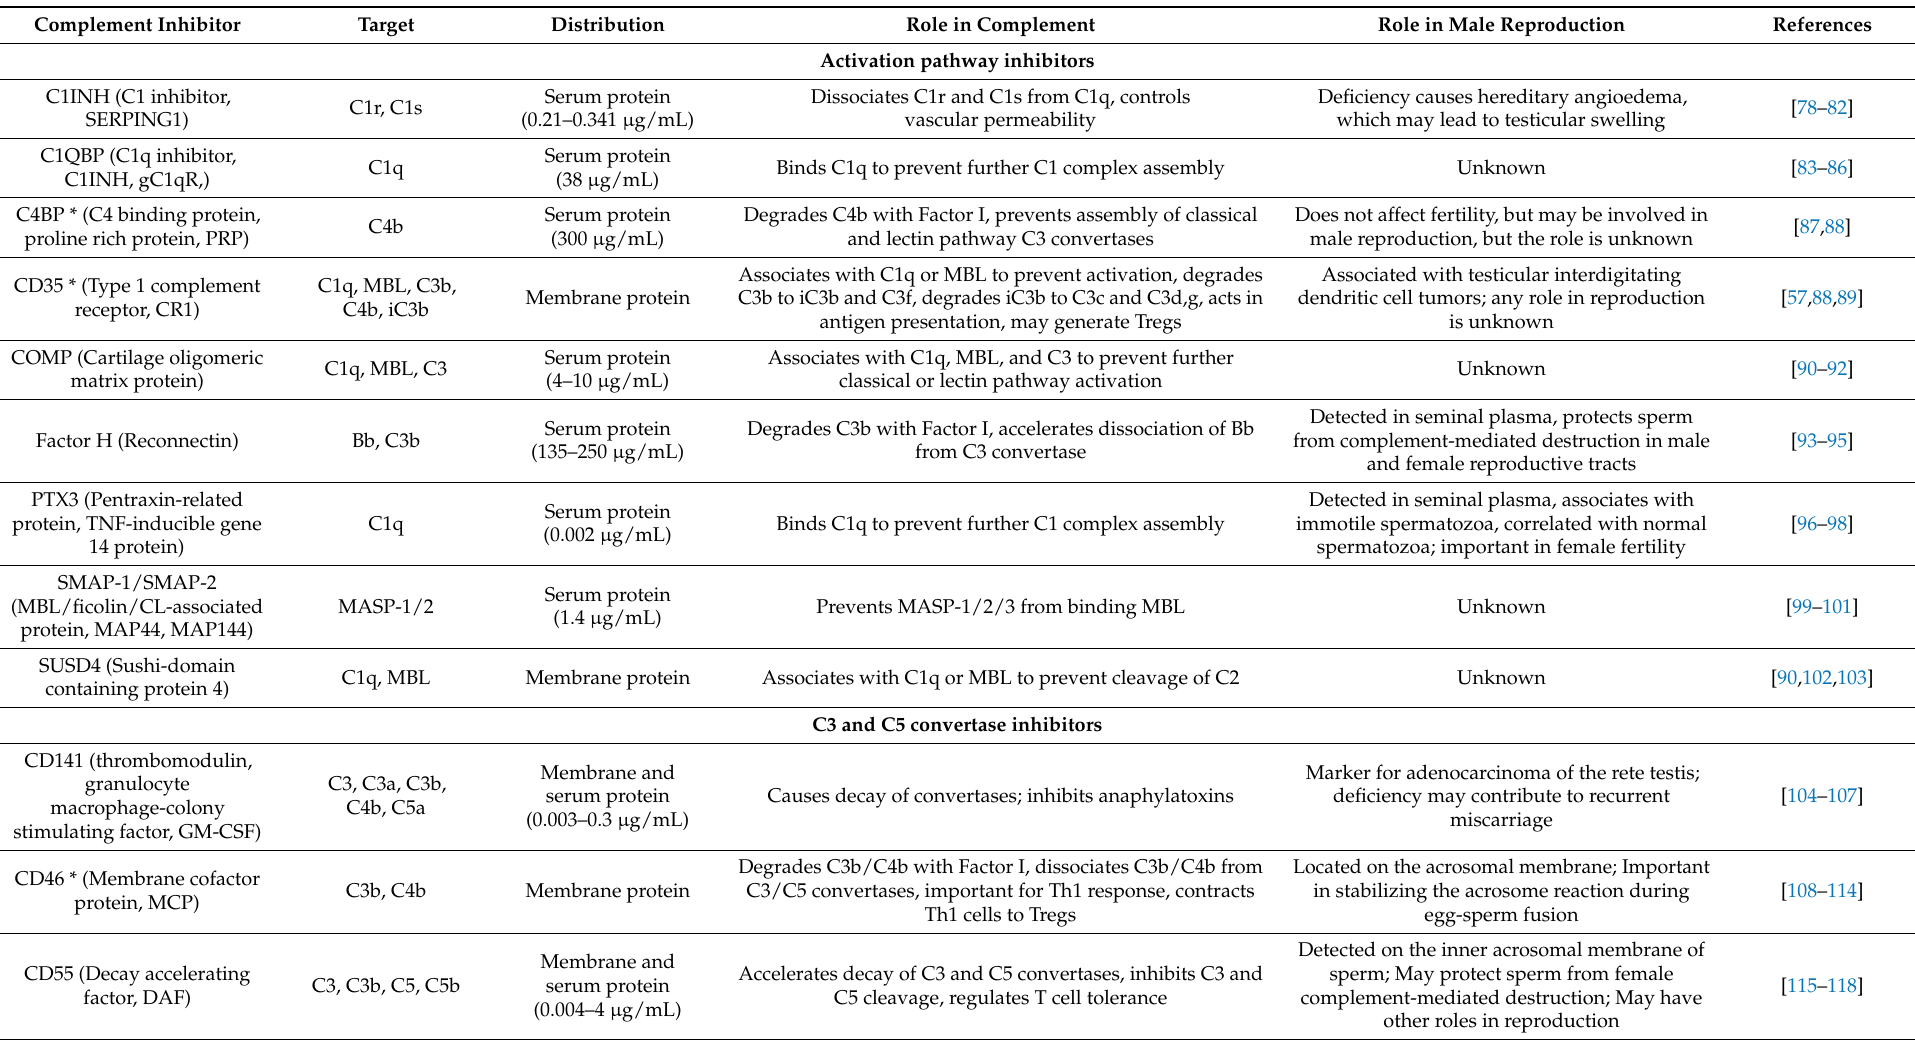
Table 2. Complement inhibitory